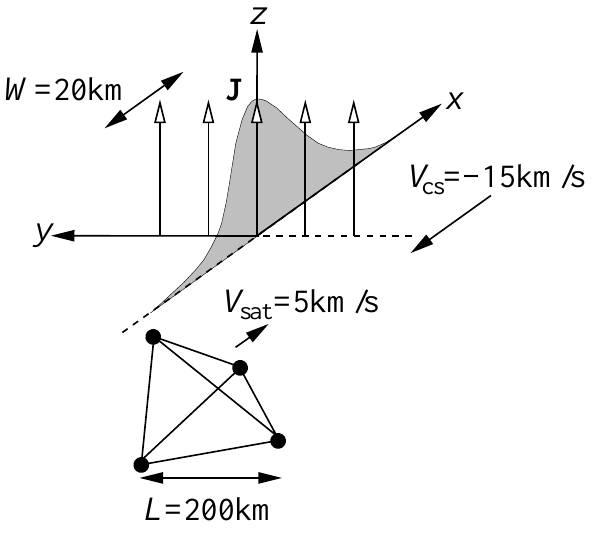
Fig. 2. Setup for a test run on synthetic magnetic field data. Rela- tive to a fixed reference system, the spacecraft and the structure are moving with + 5km/s and − 15km/s, respectively.